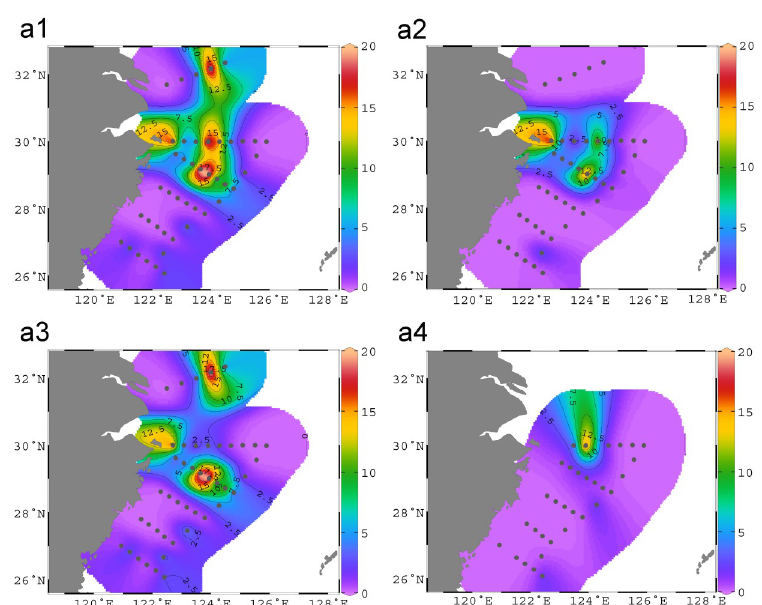
Fig 2. Horizontal distributions of L . polyactis in the East China Sea. Black dots indicate sampling stations. The x- axis and y-axis represent longitude and latitude, respectively. Concentrations of eDNA are depicted with gradient colors. Color bar scales indicate the log-transformed eDNA concentrations. (a1): average eDNA concentrations, (a2): eDNA concentrations in Layer1 (surface), (a3): eDNA concentrations in Layer2 (10m-50m), and (a4): eDNA concentrations in Layer3 (50m-104m). The eDNA hotspots were found in the Yushan fishing ground (sampling sites: S02-4, S02-5, S02-7), the Zhoushan fishing ground (S01-4, S01-1, S01-5), and the Dasha fishing ground (S00-4). New offshore spawning grounds (S01-5 and S02-5) were